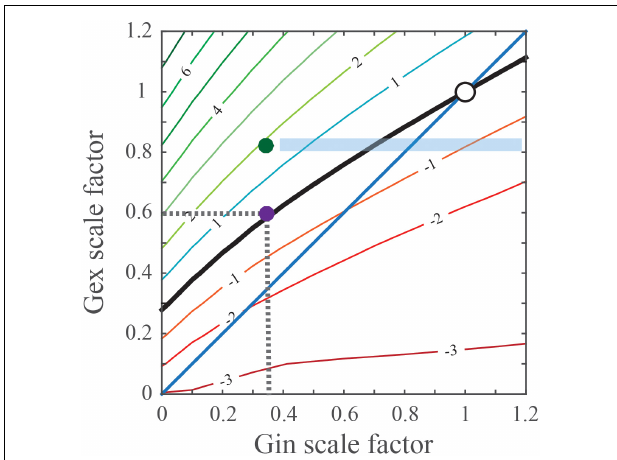
FIGURE 1 | Predicted changes in excitatory and inhibitory conductances that maintain a normal/wild type-sized PSP. Simulation calculates the effect of differentially scaled excitatory (Gex) and inhibitory (Gin) conductance combinations on the peak change in the membrane potential (Vm) of postsynaptic cortical PYR neurons. Points on the black ‘PSP stability contour’ line comprise the postsynaptic Gex and Gin conductance combinations that maintain a wild type-sized PSP. For example, the purple dot ( • ) on the contour line indicates that inhibition was reduced by 65%, which is indicated as 0.35 on the x-axis, whereas excitation was reduced by 40% and is indicated as 0.6 on the y-axis. The blue diagonal or unity line indicates numerically equal changes in Gex and Gin conductances. For regions where the contour rests above the diagonal, when Gex decreases, Gin must decrease more than Gex to maintain a normal-sized PSP. Compensatory changes in Gin can potentially be imperfect, maintaining balance in one brain region but not another. The green dot ( • ) illustrates a hypothetical case where Gex is reduced but features of hyperexcitability are present, i.e., PSPs are 2 mVs larger. For this case, the blue shaded rectangular area predicts that pharmacological treatments selectively increase synaptic GABA, may induce circuit hypoexcitability as Gin levels near